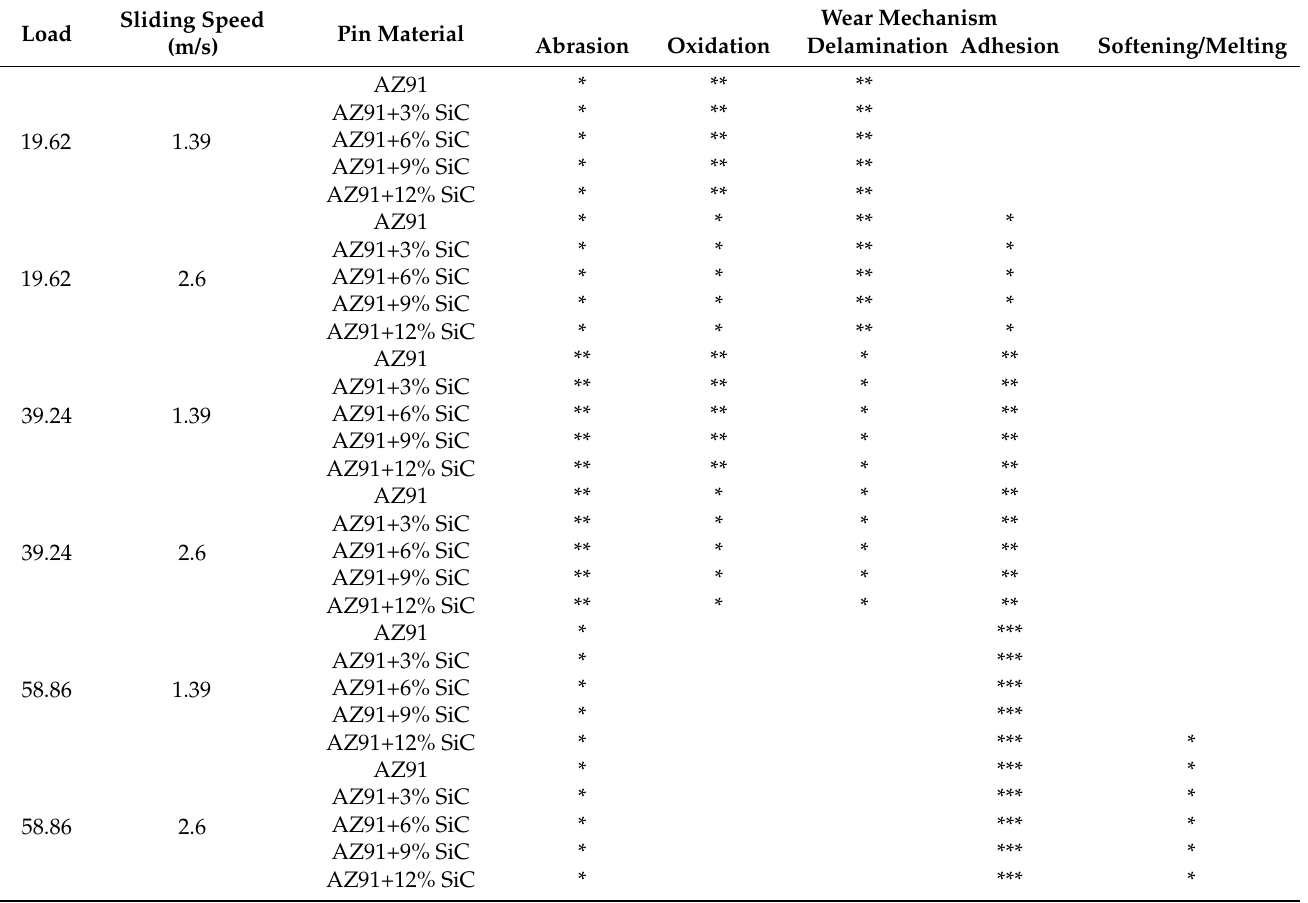
Table 2. Summary of wear mechanisms for different combinations of normal load, sliding speed and pin materials. Sliding Load